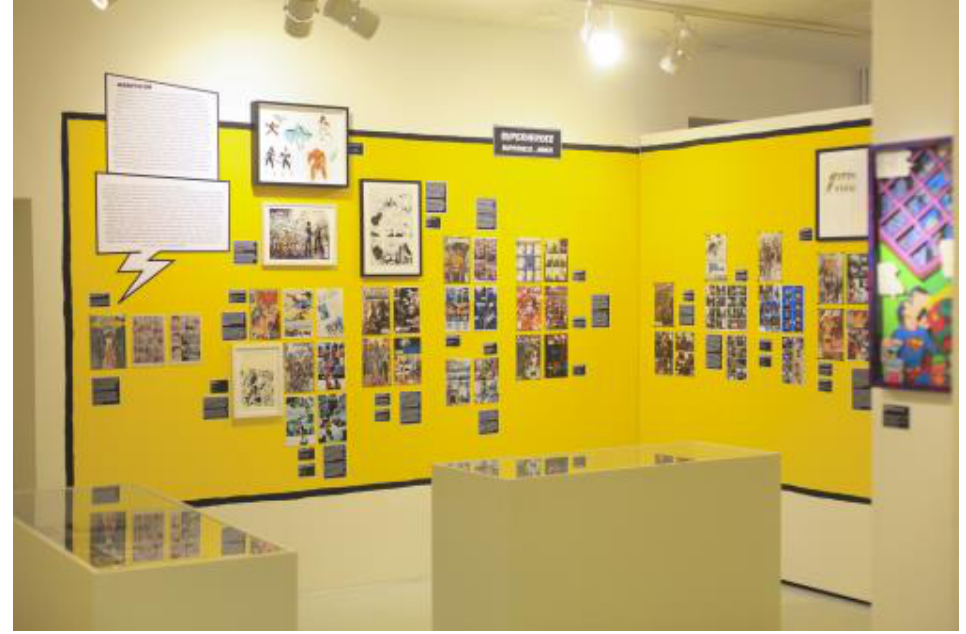
Figure 2 Installation view , “Mainstream” section, SuperQueeroes – Our LGBTI* Comic Book Heroes and Heroines, Schwules Museum*, Berlin, curated by Michael Bregel, Kevin Clarke, Natasha Gross, Hannes Hacke, Justin Hall, Markus Pfalzgraf, Mario Russo. Photograph courtesy Robert M Berlin/Schwules* Museum. Northstar’s story, among others, reflects the departure of mainstream comics from their heteronormative industrial moorings, as well as productively expands the sphere of representations rendered legitimate, both within and beyond comics. Nevertheless, one must question whether narratives like Northstar’s simply react to a dominant teleology of mainstream gay politics, rather than actively envisioning a politics rooted in the heterogeneity of queer experience. 7 While the independent comics presented testify a diversity of desires through affective and imaginative representations derived from lived realities, the mainstream comics section compounds the pragmatic reduction of queer politics into gay visibility. 8 This instance counterproductively ris ks advocating a “homonormative time line,” where linear gay expectations either hegemonically singularize queer lives or further pathologize ones that fail to conform. 9 Moreover, the challenges raised by